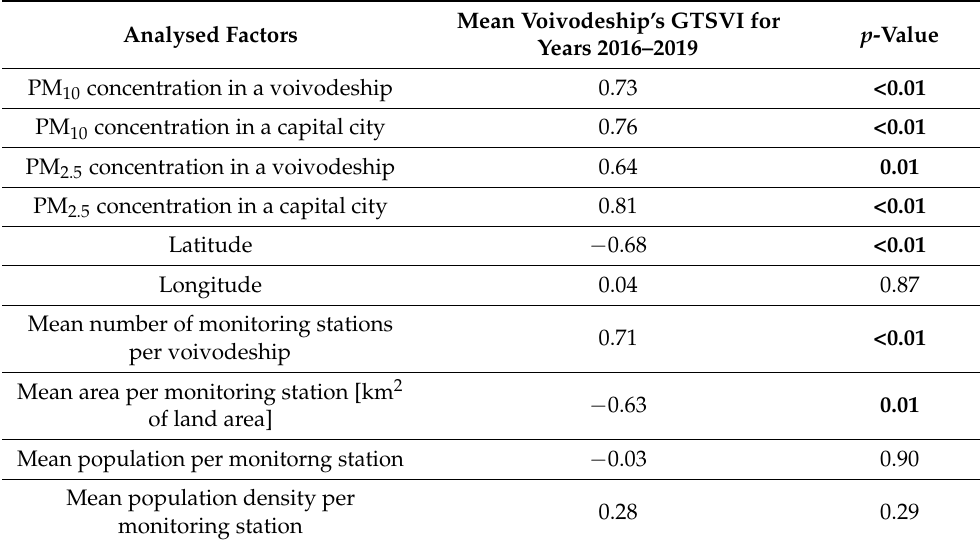
Table 6. Pearson product-moment correlation coefficients for correlations between mean voivode- ship’s GTSVI for years 2016–2019 and corresponding variables. Mean Voivodeship’s GTSVI Analysed Factors